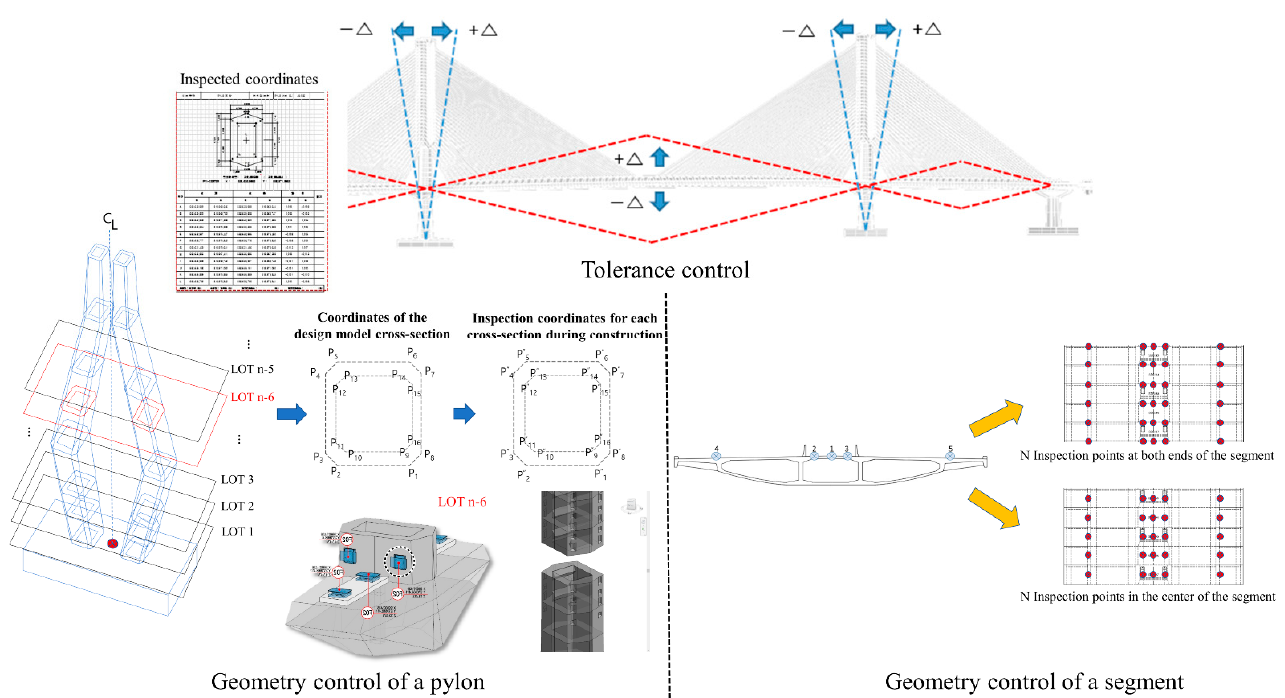
Figure 10. Consideration of geometry measurement during construction stages.